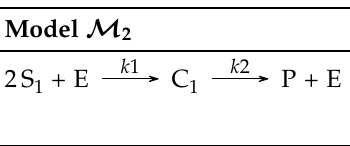
Table 3. Reaction scheme of model